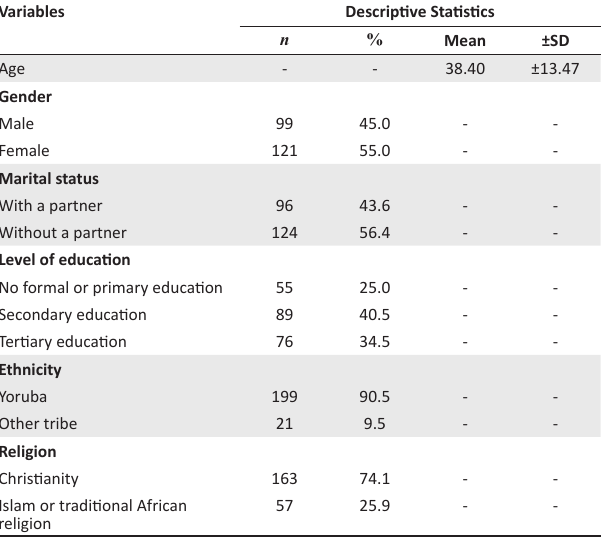
TABLE 2: Sociodemographic variables of respondents. Variables